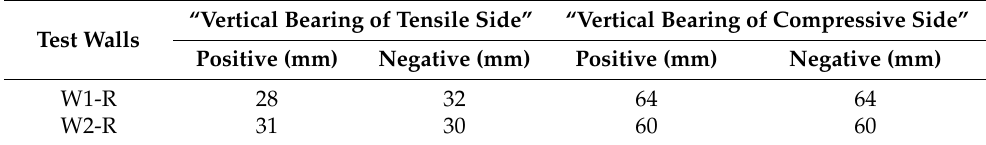
Table 3. Top displacement when “vertical bearing”